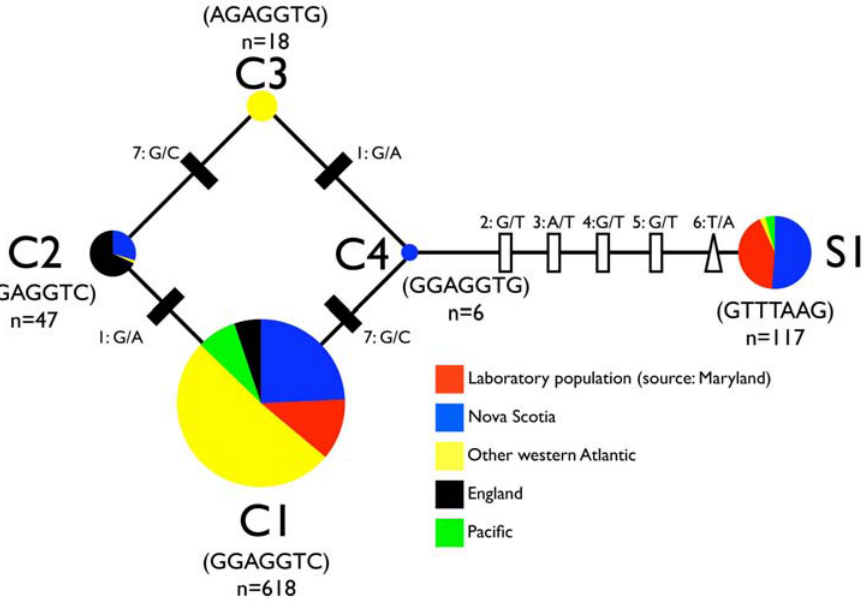
Figure 4. Haplotype tree depicting the relative abundances and mutational distances between the five nfkb variants. The evolution of the 5 Nematostella nfkb variants can be explained by two mutation events at SNP1, two events at SNP7, and five separate events at SNPs 2–6. Circles indicate individual alleles. The overall abundance of each allele is proportional to circle area. Colored wedges depict the fraction of each allele that comes from a given geographic region. Silent mutations are indicated by rectangles. The missense mutation underlying the Cys/Ser polymorphism in the DNA recognition loop is indicated by a triangle. doi:10.1371/journal.pone.0007311.g004 PLoS ONE |